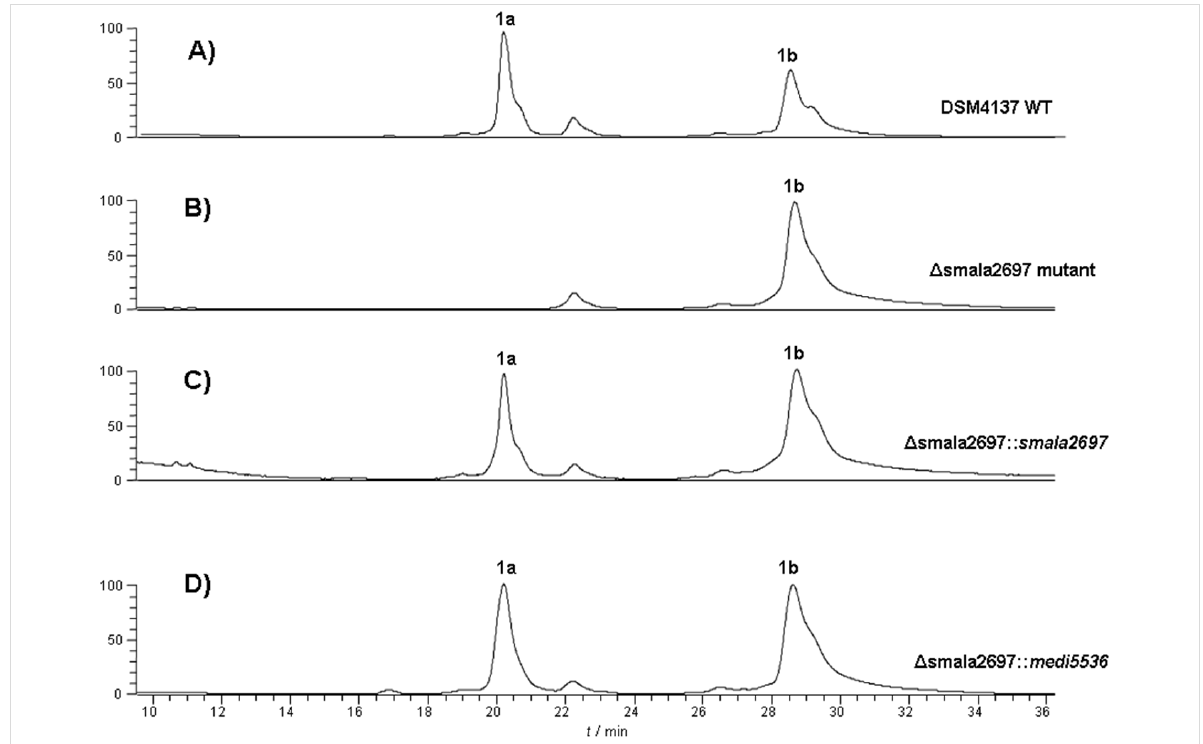
Figure 2: HPLC–UV–MS analysis of polyenes from DSM4137 wild type and mutants. A) LC–UV (360 nm) trace of mycelium methanol extract from DSM4137 wild type, showing the production of clethramycin ( 1a ) and desulfoclethramycin ( 1b ). B) LC–UV (360 nm) trace of mycelium methanol extract from the Δ smala2697 deletion mutant. In the mutant, production of 1a was completely abolished. C) LC–UV (360 nm) trace of mycelium meth- anol extract from the Δ smala2697 deletion mutant complemented with smala2697 from DSM4137. D) LC–UV (360 nm) trace of mycelium methanol extract from the Δ smala2697 deletion mutant complemented with the polyene cluster-associated slf gene ( medi5536 ) from S. mediocidicus . Both complementations restored the production of sulfonated polyene 1a